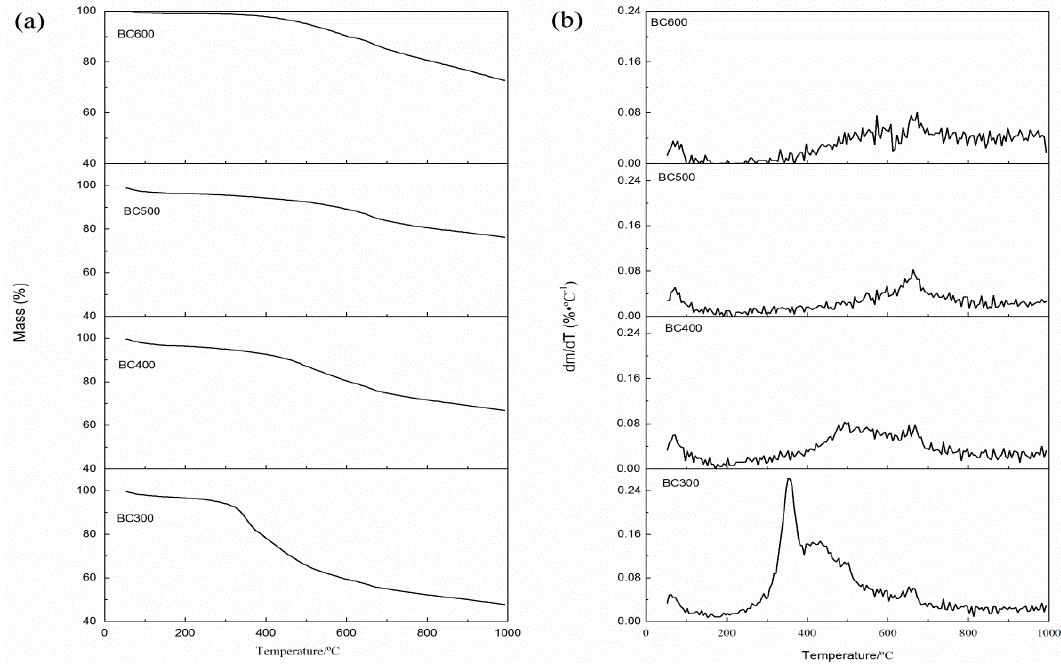
Figure 6. Thermogravimetric (TG). ( a ) Differential thermogravimetry (DTG); and ( b ) curves of biochars produced at 300 °C, 400 °C, 500 °C and 600 °C, respectively.